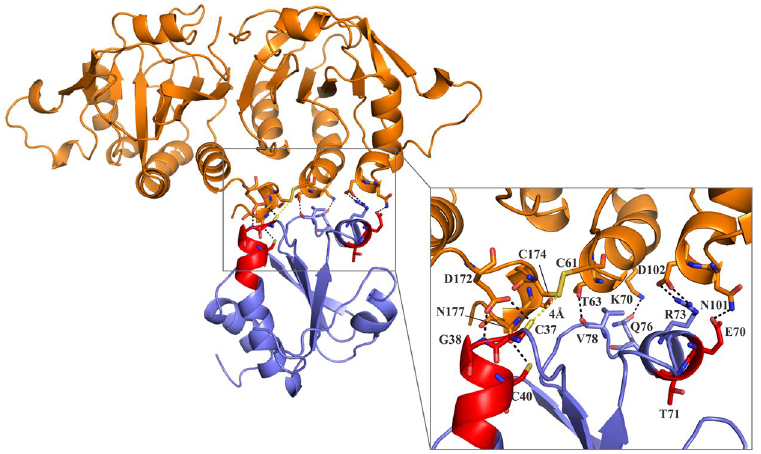
Figure 8. A model of mycobacterial TrxC-AhpC complex based on the NMR titration experiments. TrxC (PDB ID: 2L4Q) 23 is shown in blue and Mt AhpC C176S (PDB ID: 2BMX) 13 in orange color. ( Inset ) A closer view of the various interactions between mycobacterial TrxC and AhpC in the model